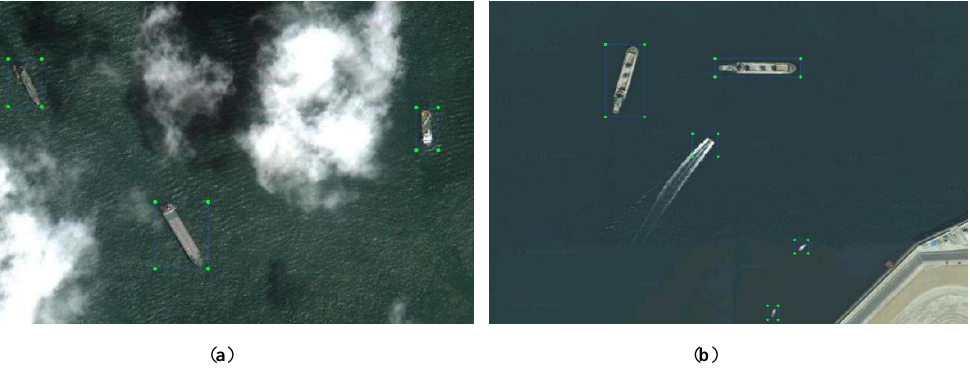
Figure 3. The labeling example of the ships’ ground-truth boxes uses the annotation tool LabelImg. ( a ) The labeling example of the ship’s ground-truth boxes in ocean image; ( b ) The labeling example of the ship’s ground-truth boxes in harbor scene.